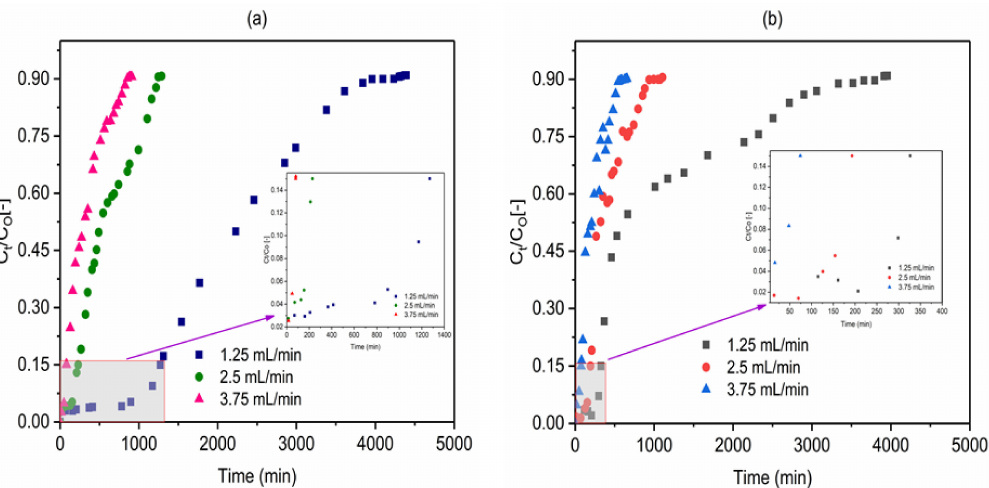
Figure 7. Effect of influent flow rate on the breakthrough behavior of fluoride in ( a ) VPum: 0.075–0.425 mm and ( b ) VSco: <0.075 mm (pH 2; C O : 10 mg/L; bed depth 10